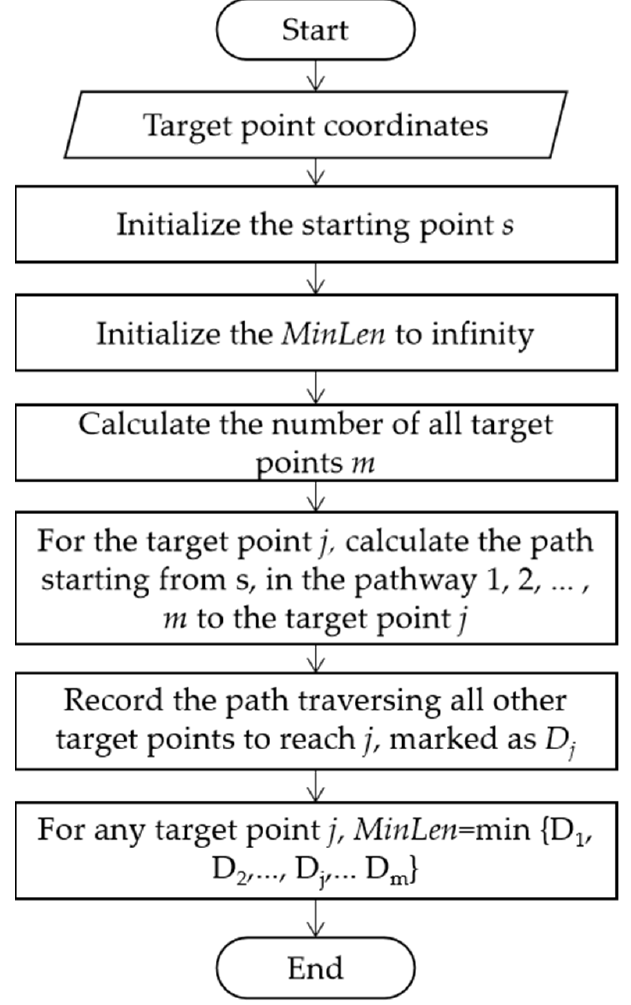
Figure 4. Flow chart of the path replanning algorithm.